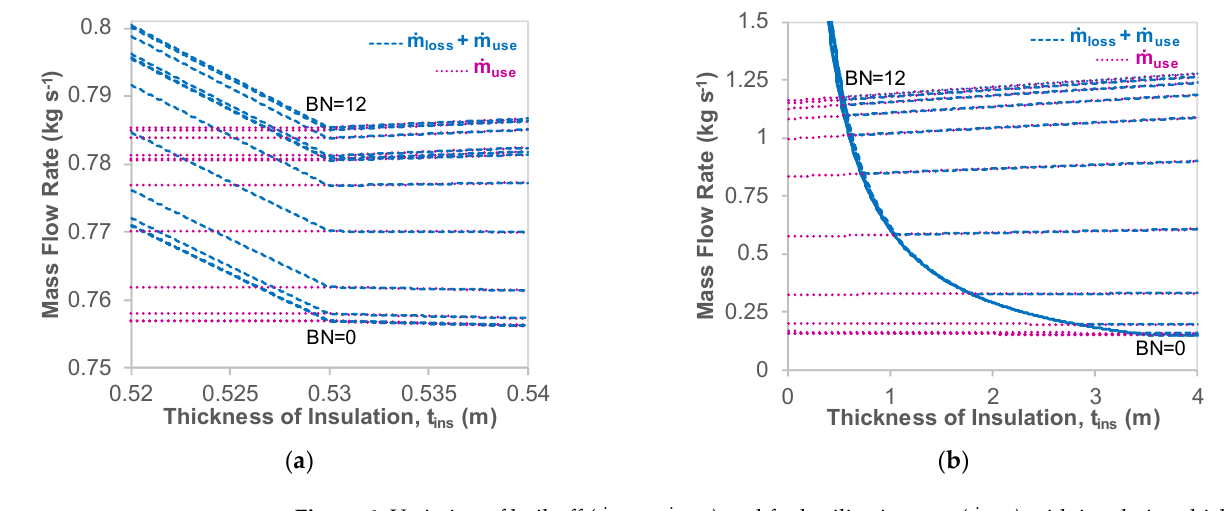
Table 10. Key to identify the symbols that represent all investigated ship designs.